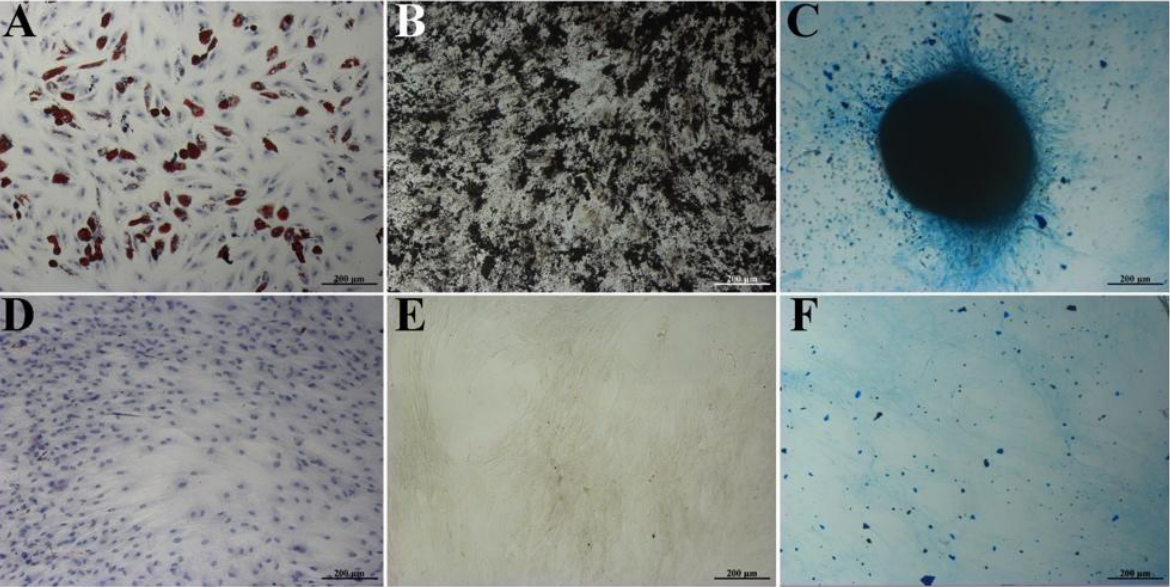
Figure 2. Differentiation of isolated BM-MSCs into adipogenic ( A ), osteogenic ( B ), and chondrogenic ( C ) lineages, as verified by Oil Red O, von Kossa, and Alcian Blue staining, respectively. ( A – C ) Dif- ferentiation media. ( D – F ) Complete DMEM media. Scale bar: 200 µm.